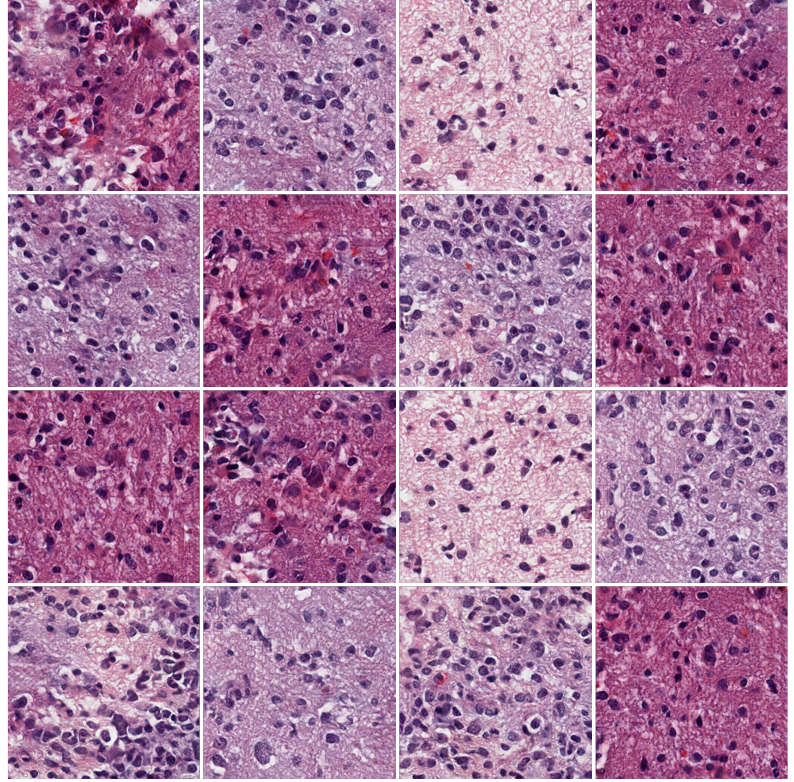
Figure 8. Oligodendroglioma samples with a resolution of 256 × 256 generated by the proposed